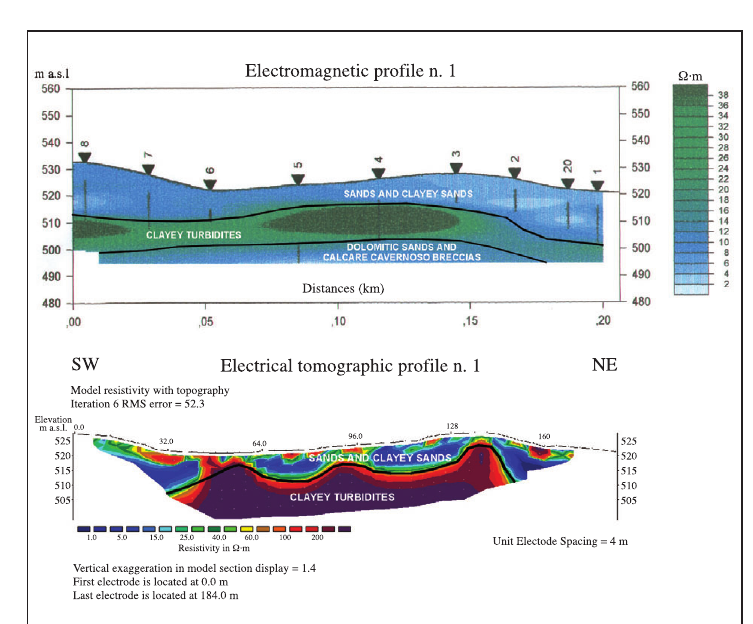
Fig. 5. Profile n.